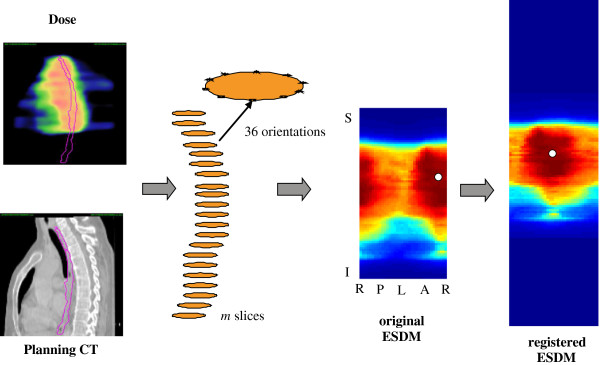
An example of generating an esophagus surface dose map (ESDM). The pixel with the highest dose (in white) is registered to the center location in the registered ESDM through translation and rotation of the original ESDM.